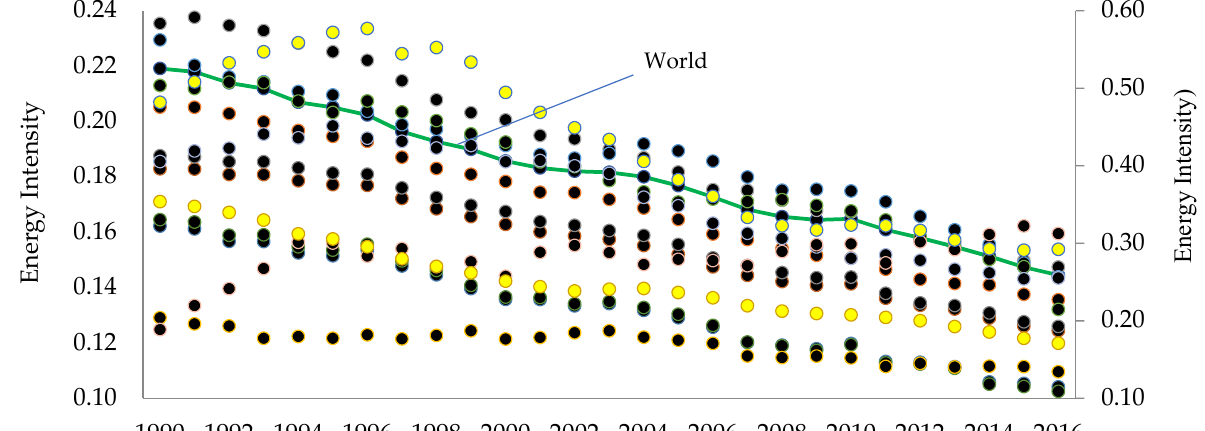
Figure 1. Trends in energy intensity (1990–2016). Notes: Energy intensity at constant purchasing power parities (koe/$2005). This figure includes trends from all regions, including Africa, America, Asia, BRICS and CIS countries, Europe, the European Union, the G7, Latin America, the Middle East, North America, OECD countries, and the Pacific. All regions, except CIS and BRICS countries, are plotted against the primary axis. CIS and BRICS countries are plotted against the secondary axis. These two regions are plotted in yellow.